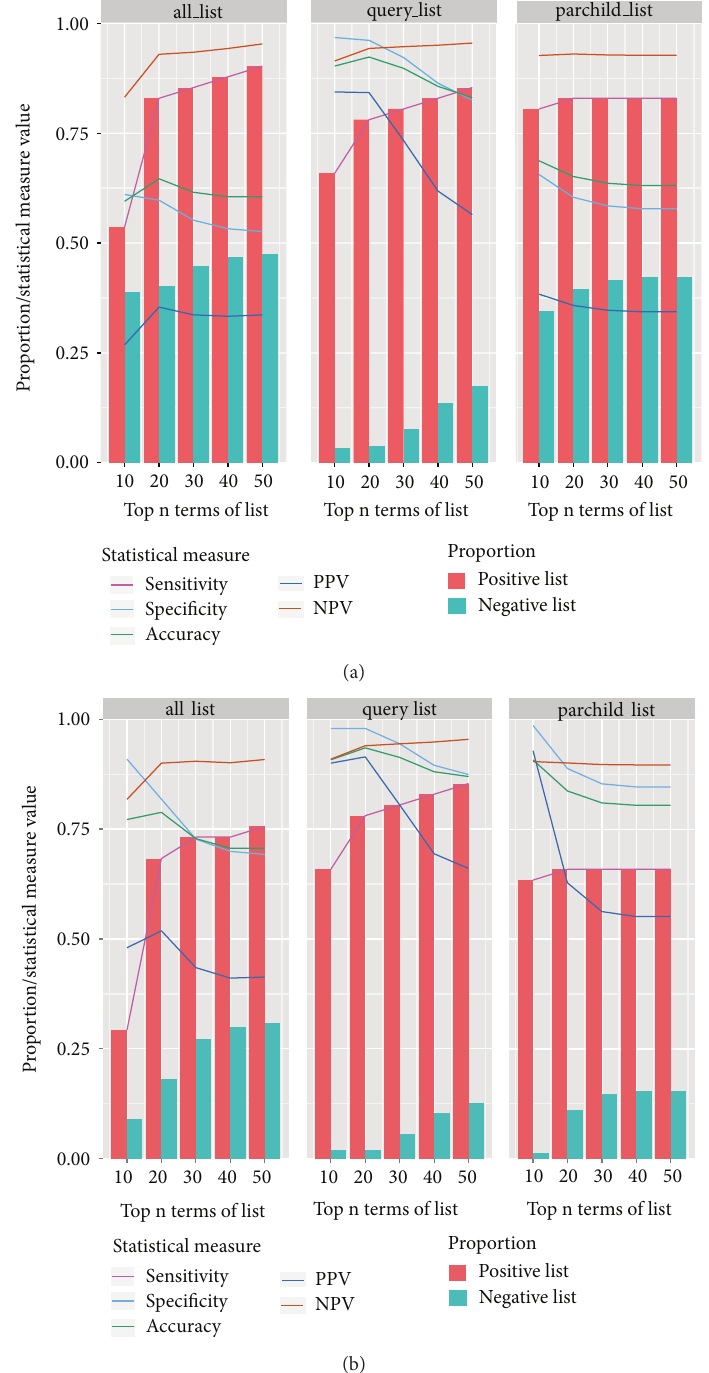
Figure 3: Statistical assessment of GOLink’s ability to predict whether or not a gene has a role in a particular Biological Process based on its Molecular Function terms. GO annotation terms from genes in a positive and a negative list were matched against terms in the three GOLink terms lists. (a) The measures of sensitivity, specificity, accuracy, positive predictive value, and negative predictive value as well as the proportion of genes reported in the positive and negative lists. (b) The same measures but showing the impact following the removal of 11 known true positives from the negative list and the removal from the GOLink terms lists of the term “protein binding,” which has relevance across both the positive and negative gene